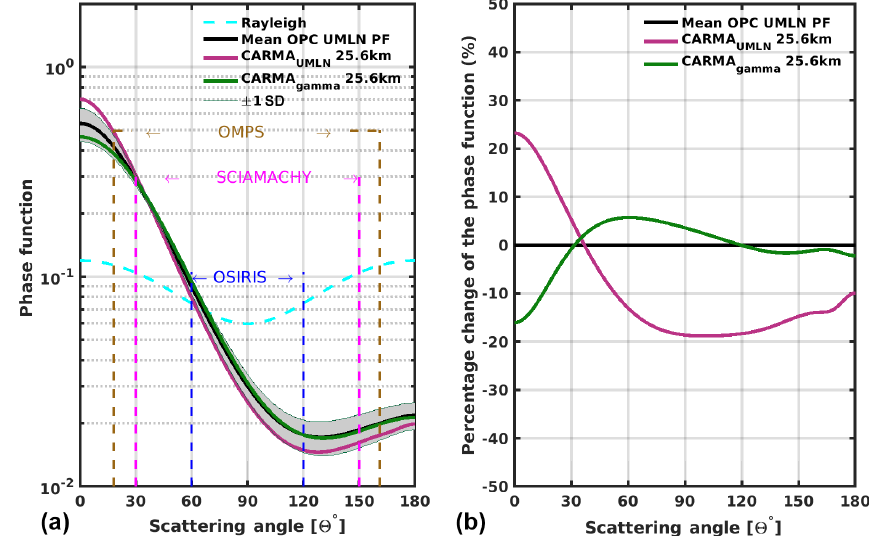
Figure 10. Panel (a) shows the mean and the standard deviation of phase functions, for the wavelength of 675nm, derived from the fits of the UMLN distribution for all the OPC data used for the months of June, July, and August (JJA) at altitude 25km compared to the phase functions derived from the UMLN and gamma fits to the CARMA model data at altitude 25.6km. Panel (b) shows the percent changes between the UMLN-derived phase functions from the OPC data and the UMLN- and gamma-derived phase functions from the CARMA model